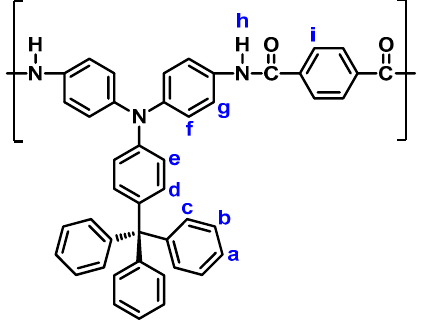
Figure 4. Structure and codes of hydrogen atoms of polyamide 5a .